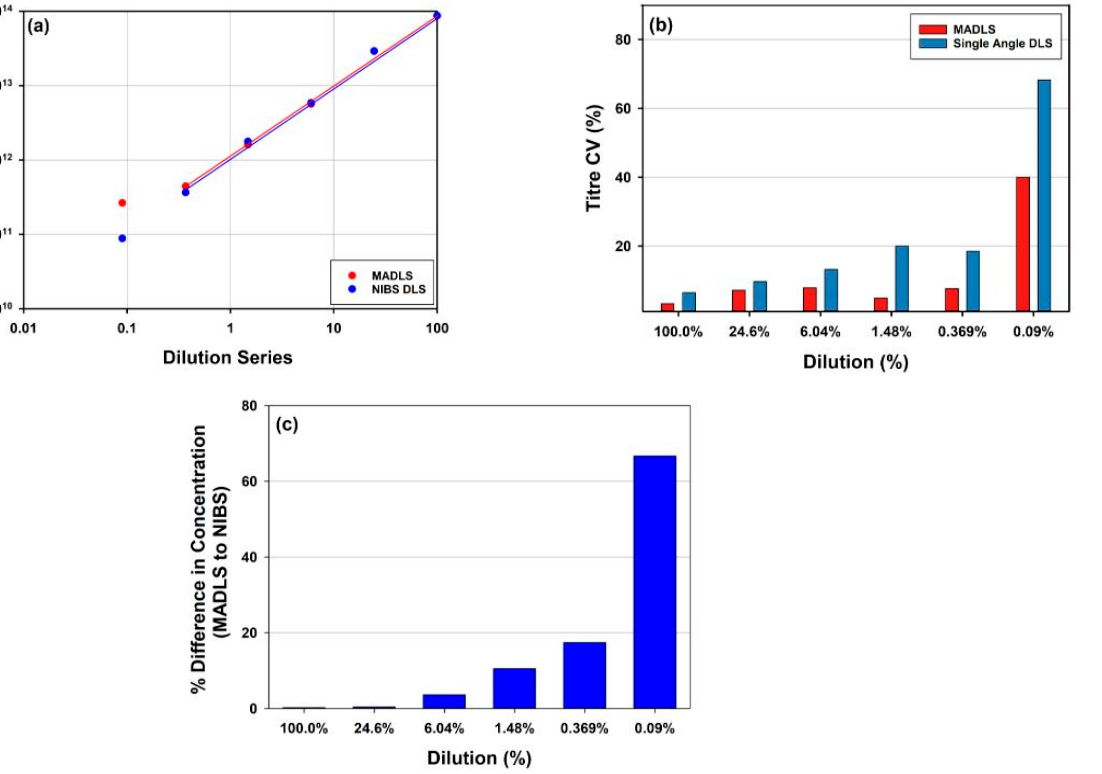
Figure 5. Comparison of rAAV5 concentrations measured using single-angle DLS (backscatter) or MADLS: ( a ) Total viral particle concentration for the sample across the dilution series; ( b ) Variability across repeat measurement for each dilution; ( c ) Deviation in concentration value determined with single-angle DLS versus MADLS measurements.